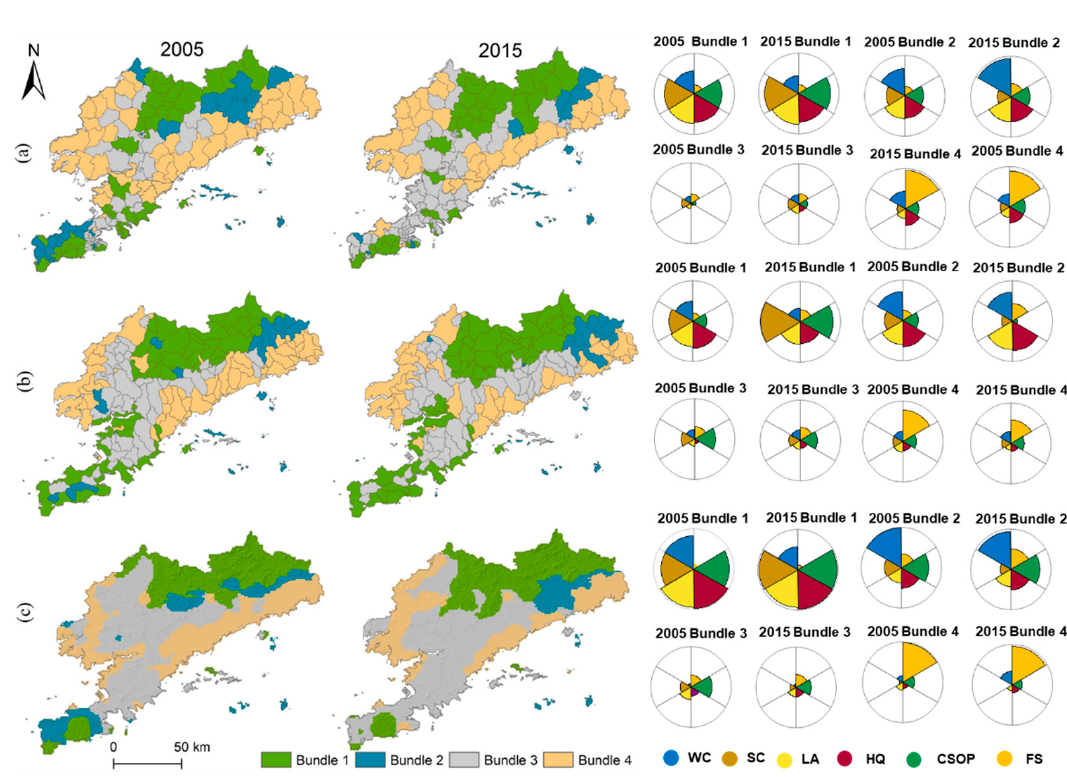
Figure 4. Spatial distribution of ES bundles in Dalian at the three scales of analysis from 2005 to 2015. Bundle 1–4 represents the bundles of ecological conservation, water conservation, ecological depletion, and food supply, respectively; ( a ) county scale, ( b ) watershed scale, ( c ) 1 km grid scale.